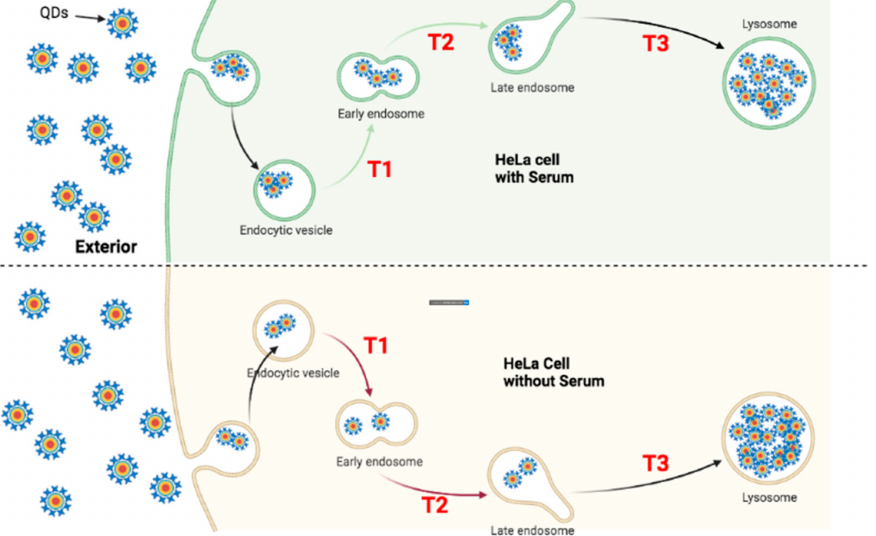
Figure 15. Proposed transportation kinetics of QDs in HeLa cells grown in the media with and without serum for 48 h. A figure illustrating intracellular trafficking kinetics of QDs varies in HeLa cells grown with serum ( Upper ) and HeLa cells grown without serum ( Bottom ) 48 h after the treatment of QDs. (T1) indicates the transition of QDs from the endocytic vesicle towards the early endosome; (T2) indicates the transition of QDs from the early endosome towards the late endosome; (T3) indicates the transition of QDs from the late endosome to the lysosome. Each green arrow represents a slower transit rate of QDs in comparison with its counterpart rate indicated in red. Each red arrow represents a faster transit rate of QDs in comparison with its counterpart rate indicated in green.